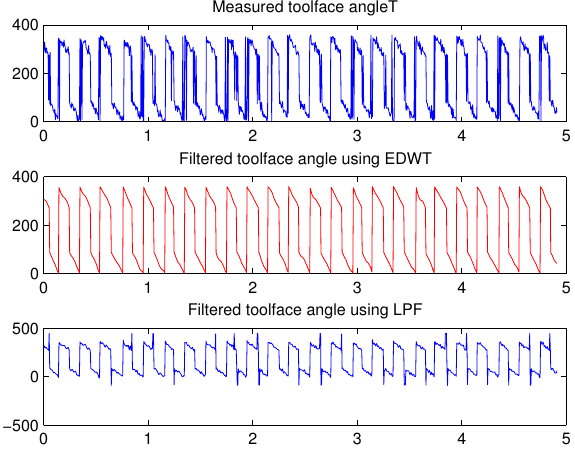
Figure 7. Comparison of tool-face angle before and after